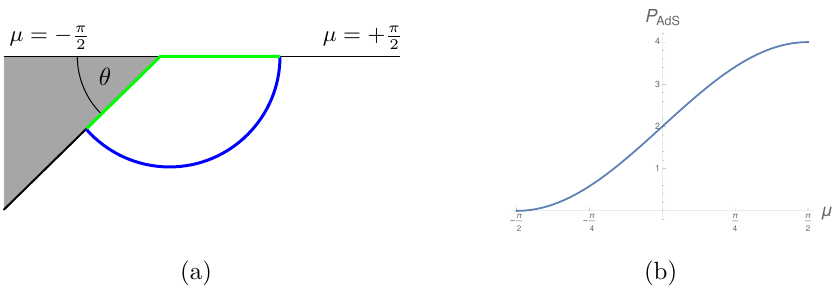
Figure 10. Left: braneworld model with coordinates (5.1) and brane angle θ . The “along the brane” geodesic connecting a point on the ETW brane to a point in the ambient CFT is shown in green, the “through the bulk” geodesic in blue. Right: P AdS and place the ETW brane at µ = µ part of the conformal boundary is µ = π